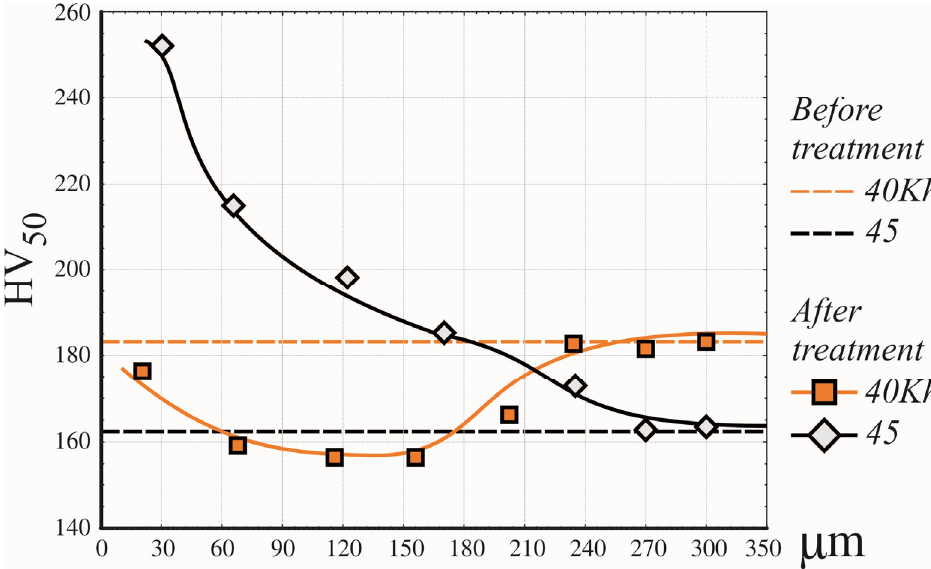
Figure 4. Microhardness profiles of specimens of 45 and 40Kh Steels.